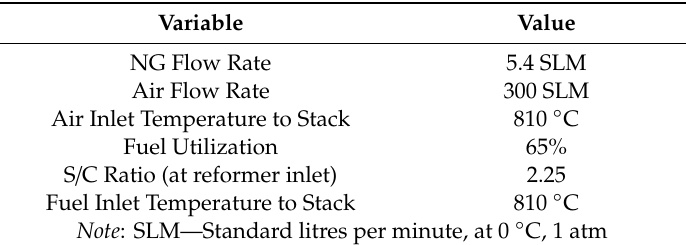
Table 2. Model input parameters for the base case